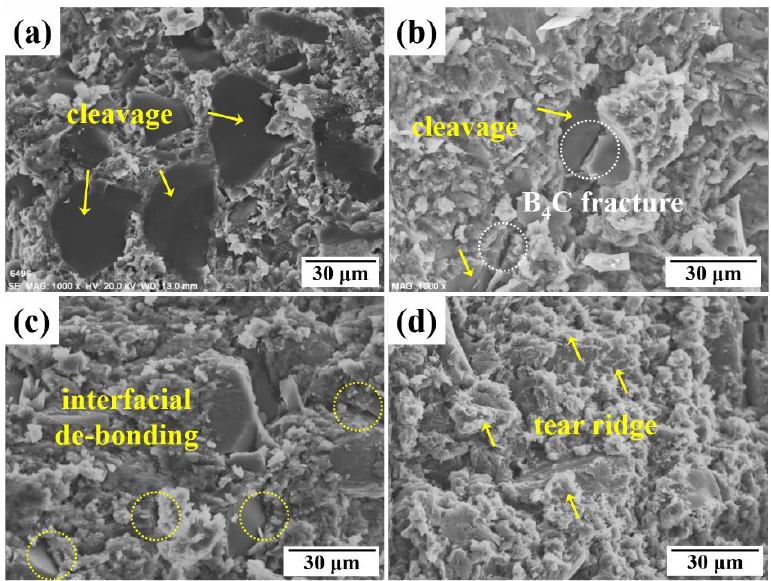
Figure 3. Fracture surface of the composite after the compressive test at ( a ) room temperature, ( b ) 100 °C, ( c ) 200 °C, and ( d ) 300 °C.